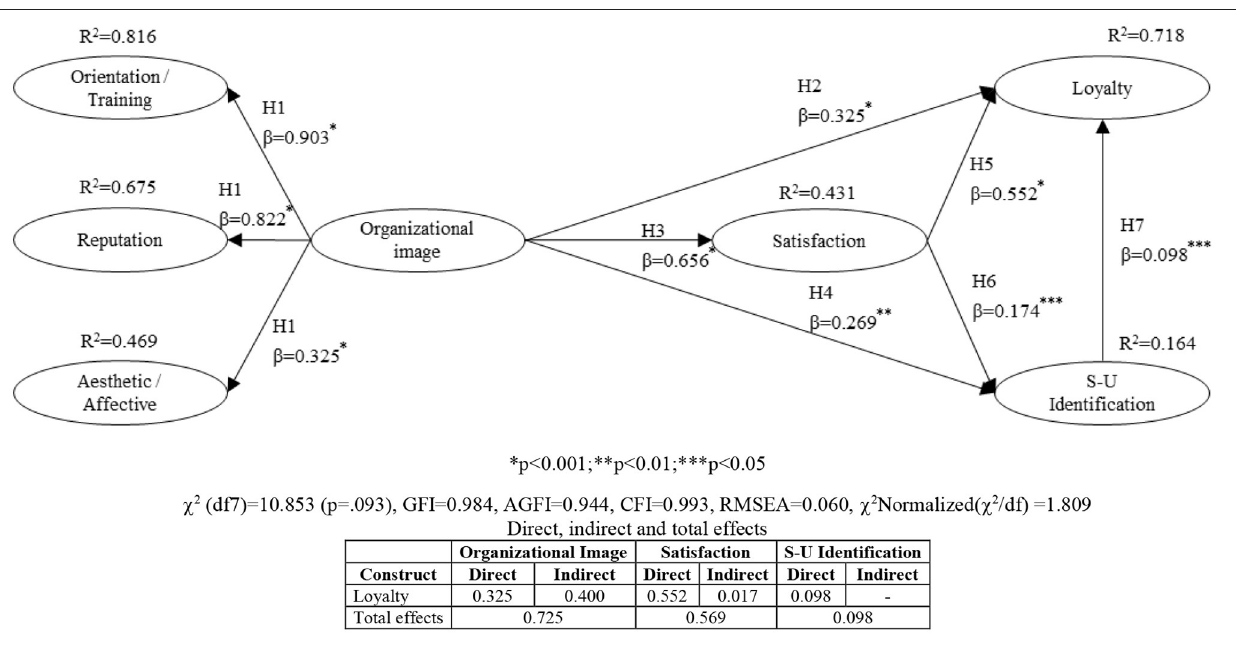
FIGURE 2 | Structural